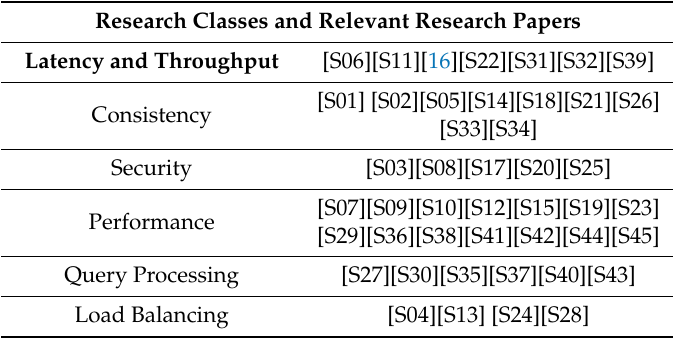
Table 5. Distribution of primary studies over